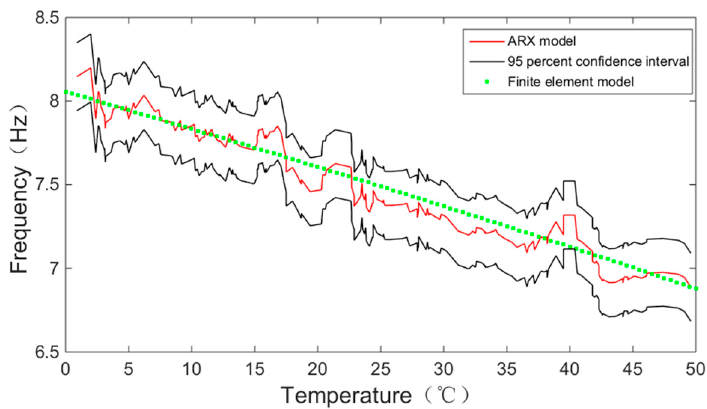
Figure 13. Frequencies of the slab vs. temperature based on ARX model, the 95 percent confidence intervals and the finite element model.